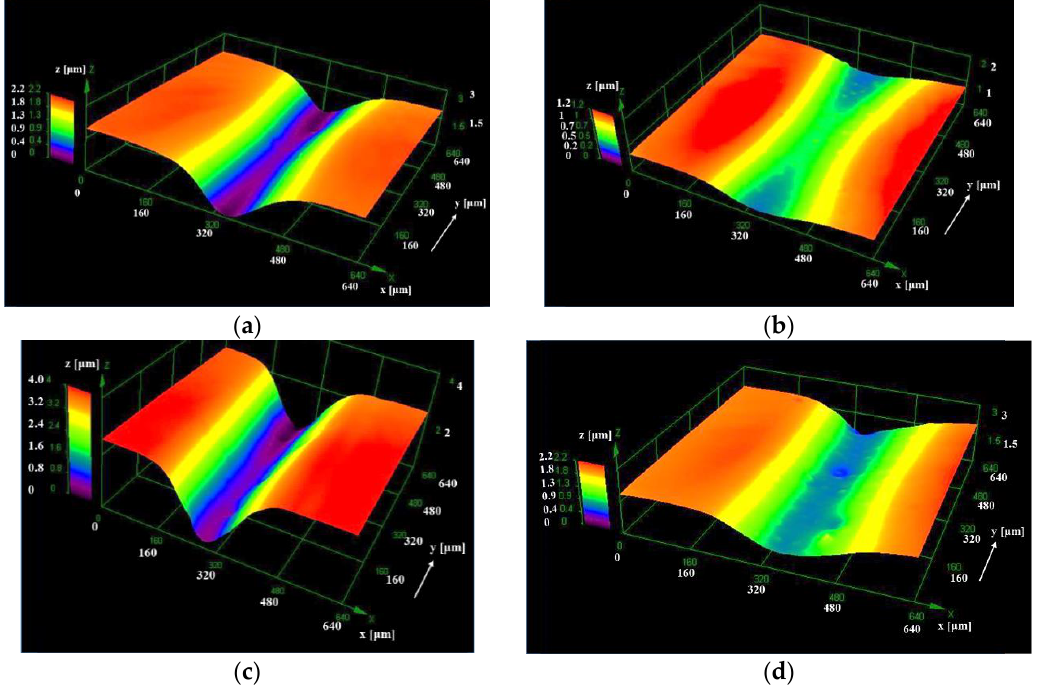
Figure 7. Three-dimensional profiles of treated flat Si wafer with He:CF 4 = 700:300 sccm and Ar:CF 4 = 700:300 sccm at V pp = 9.8 kV: ( a ) t e = 5 min in the Ar/CF4 mixture; ( b ) t e = 5 min in the He/CF 4 mixture; ( c ) t e = 10 min in the Ar/CF 4 mixture; ( d ) t e = 10 min in the He/CF 4 mixture.